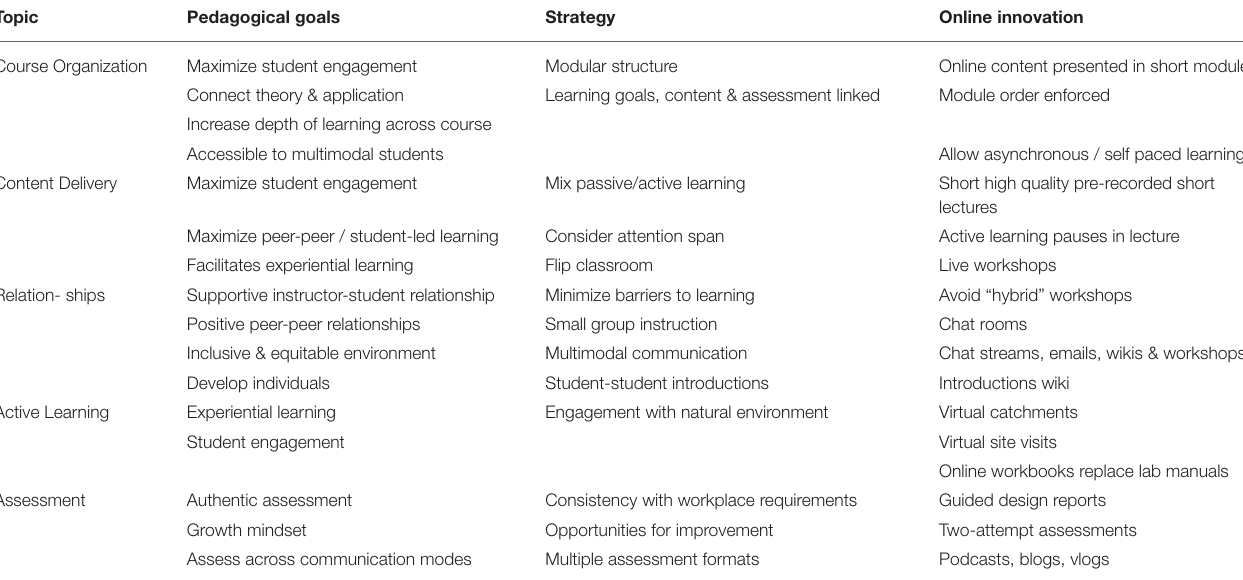
TABLE 3 | A shared pedagogical framework for the four classes discussed in this